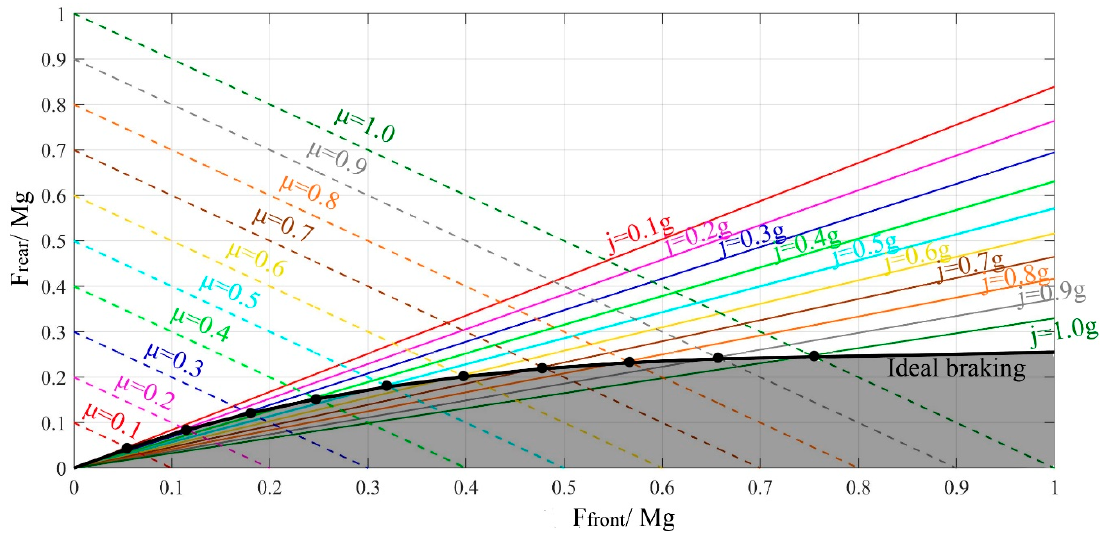
Figure 6. Ideal braking distribution curve.